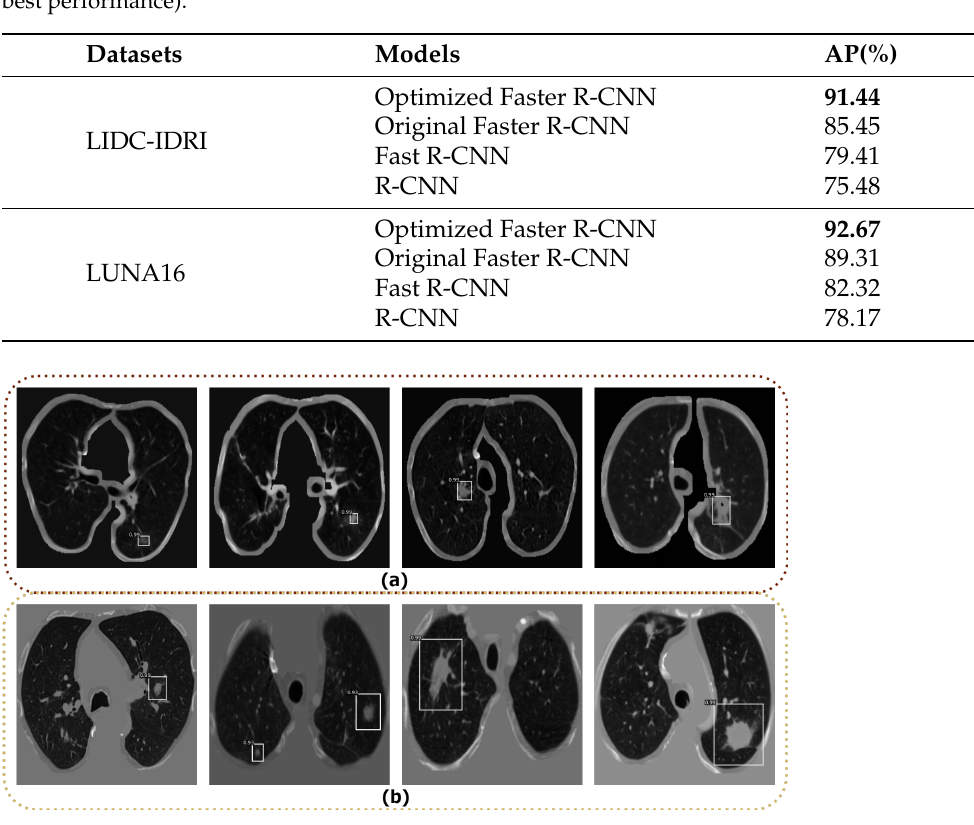
Figure 6. Examples of lung nodule detection using Optimized Faster R-CNN; ( a ) Detection results from the LIDC-IDRI dataset; ( b ) Detection results from the LUNA16